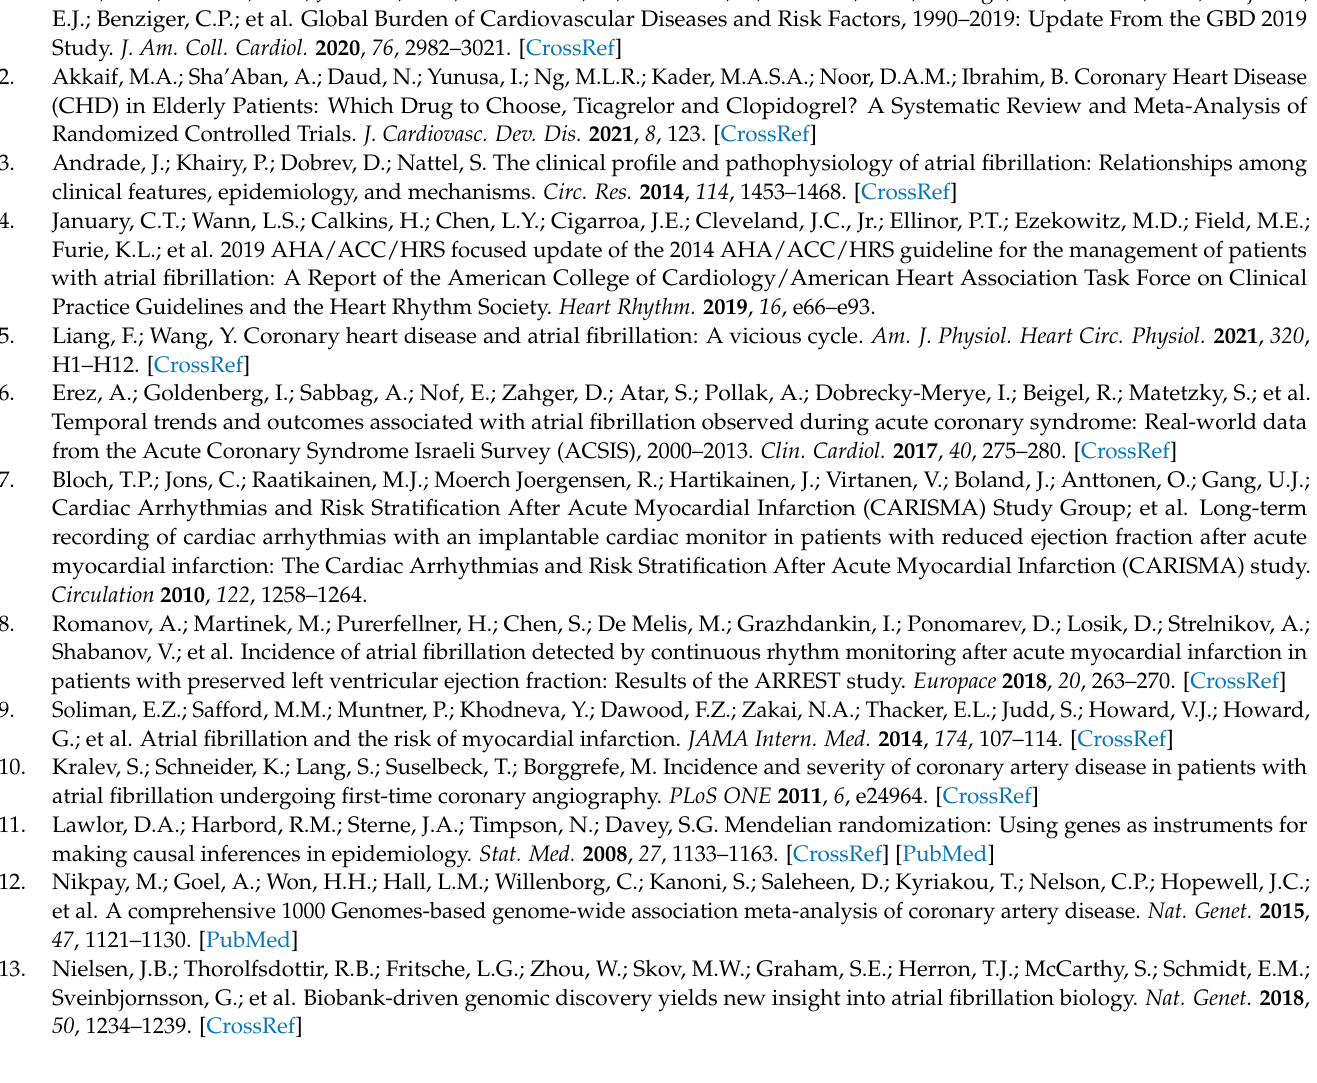
Table S2: Identified instrumental variables for atrial